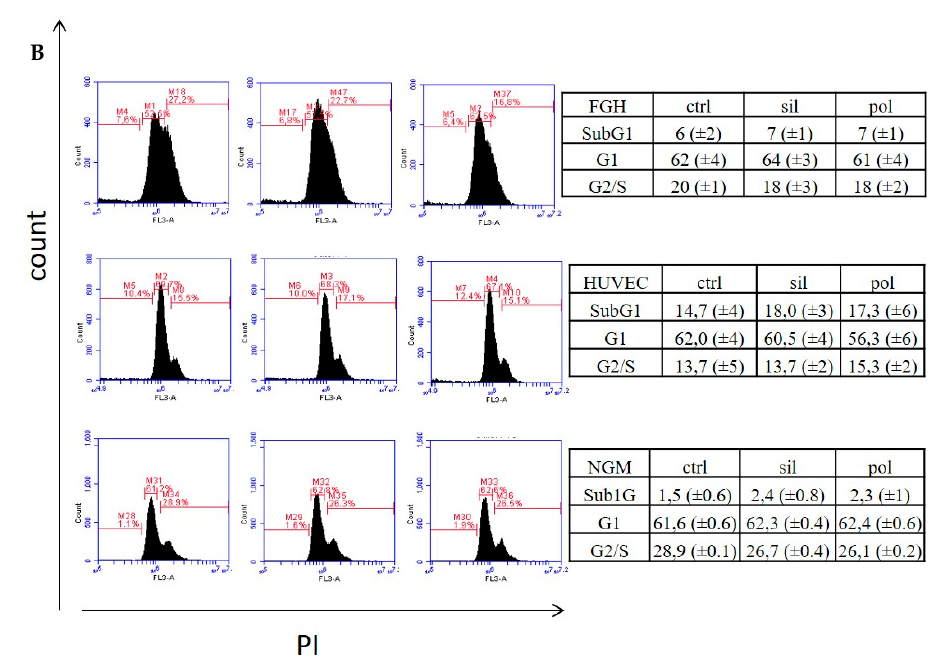
Figure 5. Effects of nanoparticles in the cell cycle of tumor and non-tumor cells. Tumor cells (panel A ) and non-tumor cells (panel B ) were incubated with polymeric (pol) or silica (sil) nanoparticles (20 μ g/mL) for 24 h. Then, cells were harvest and dyed with Propidium iodide (PI) as described in methodology section. DNA content was detected by flow cytometry for the presence of cells in different stages (SubG1, G1 and S/G2) of cell cycle. Figures are representative from 3 individual experiments .